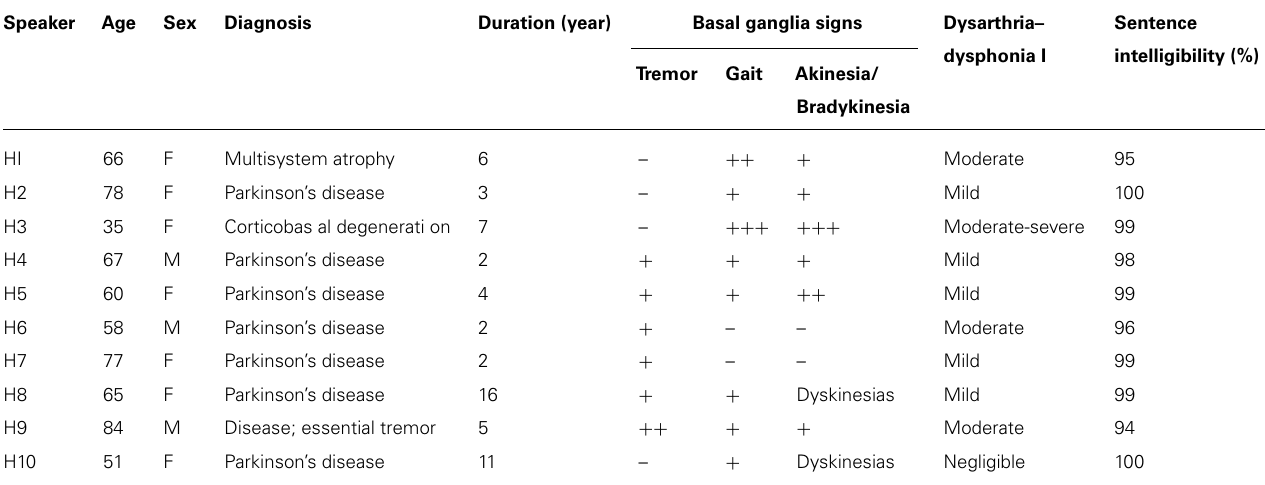
Table 2 | Clinical characteristics of participants with hypokinetic dysarthria.